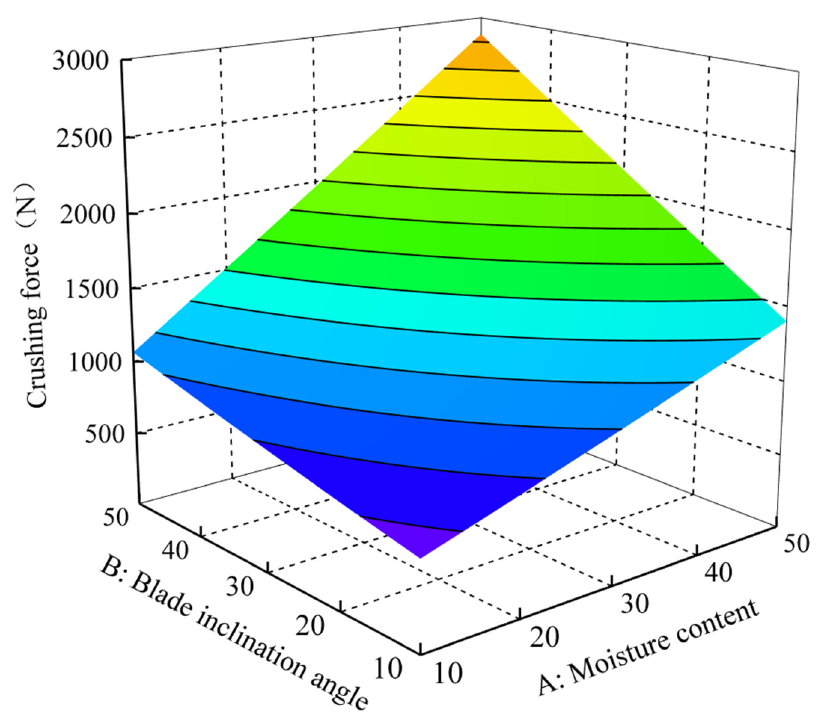
Figure 6. Interactive effect of moisture content A and blade inclination angle B on the crushing force on corn bale samples.